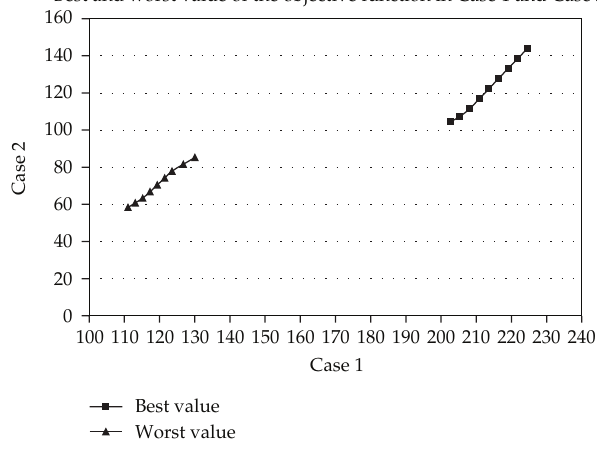
Figure 1: Best and worst value of the objective function for Cases 1 and 2.